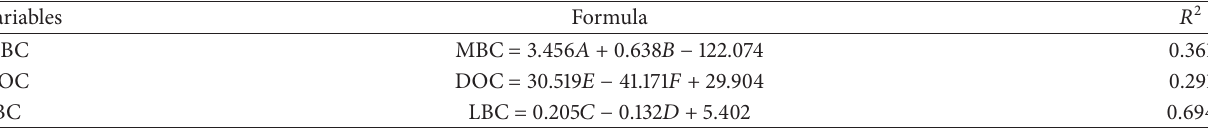
Table 3: The correlation of carbon fractions with plant parameters.